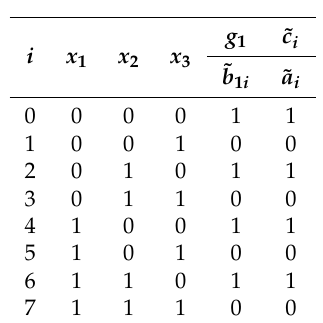
Table 2. Truth table relative to N out (The indexed parameters ˜ a and ˜ b given together with other parameters are needed only further for Algorithm